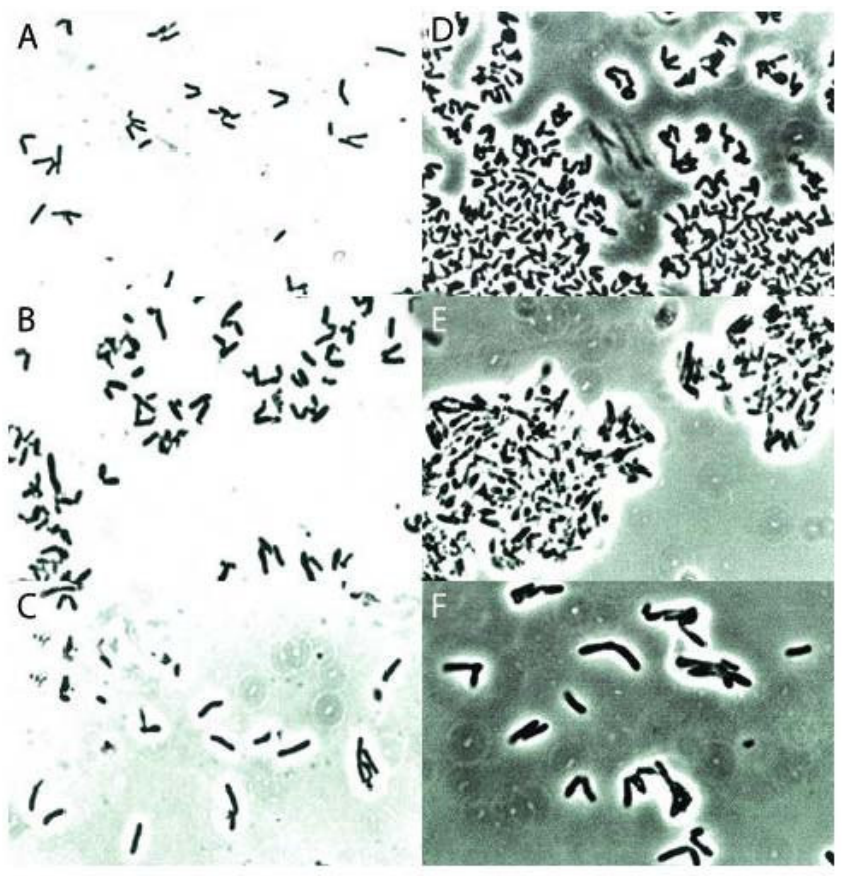
FIGURE 8. Phase contrast micrographs showing the cell morphology of each mutant strain — M1 (A), M2b (B), M2c (C), M3 (D), M5b (E), and M6b